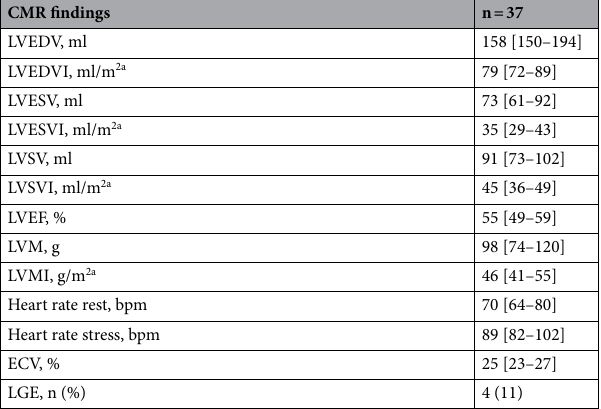
Table 2. CMR findings of the patients. CMR findings are presented as median [IQR]. CMR cardiac magnetic resonance imaging, LGE late gadolinium enhancement, LVEDV left ventricular end-diastolic volume, LVESV left ventricular end-systolic volume, LVSV left ventricular stroke volume, LVM left ventricular mass, LVEF left ventricular ejection fraction, bpm beats per minute, ECV extracellular volume. a LVEDV, LVESV, LVSV and LVM were indexed to BSA, which was calculated according to the Mosteller formula 17 .